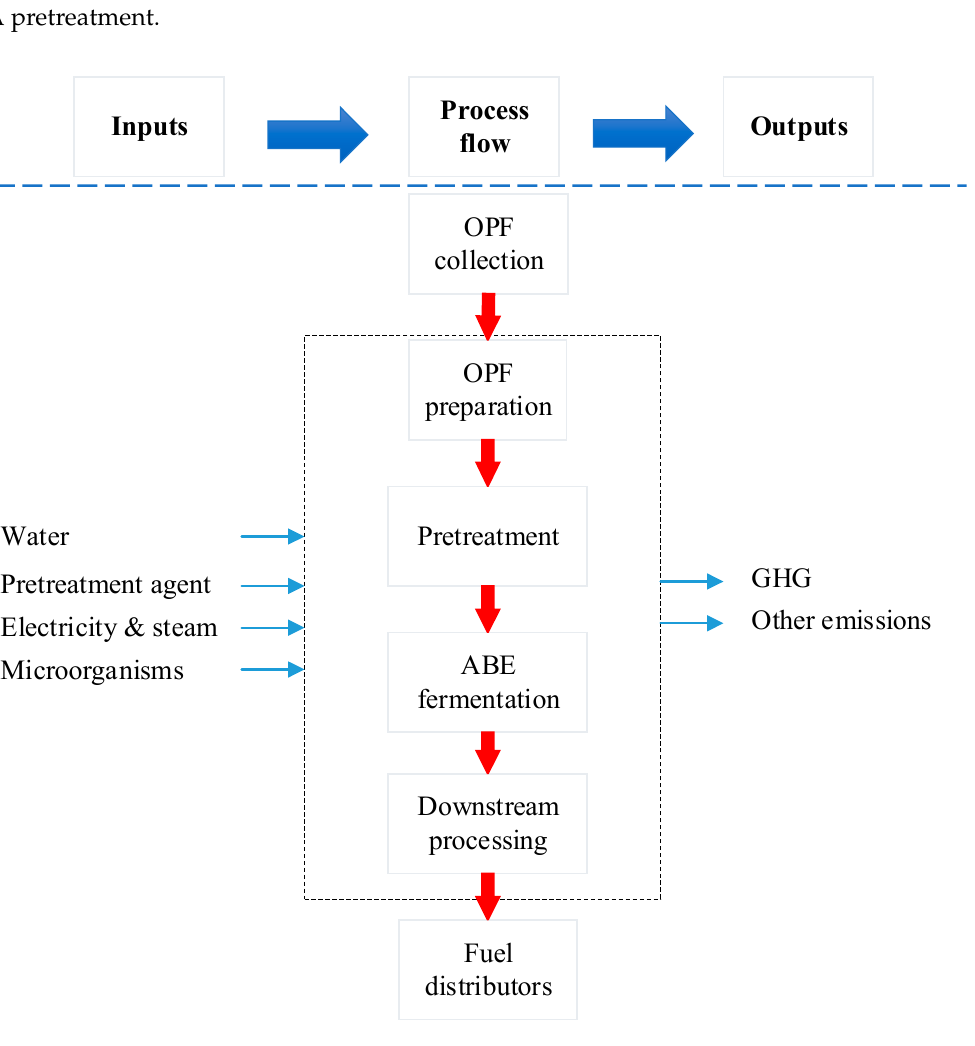
Figure 1. Gate-to-gate system boundary applied in the assessment. OPF = oil palm frond; ABE = Figure1. Gate-to-gatesystemboundaryappliedintheassessment. OPF = oilpalmfrond; ABE = Acetone Acetone Butanol Ethanol. Butanol